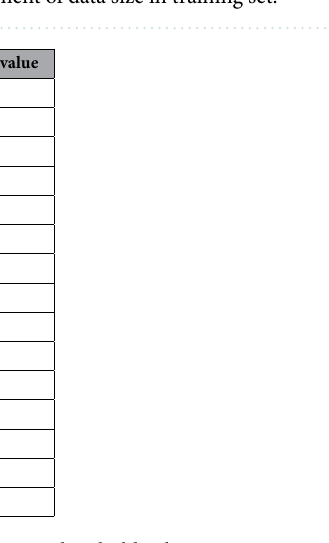
Table 2. Summary of deep learning algorithm performance according to threshold